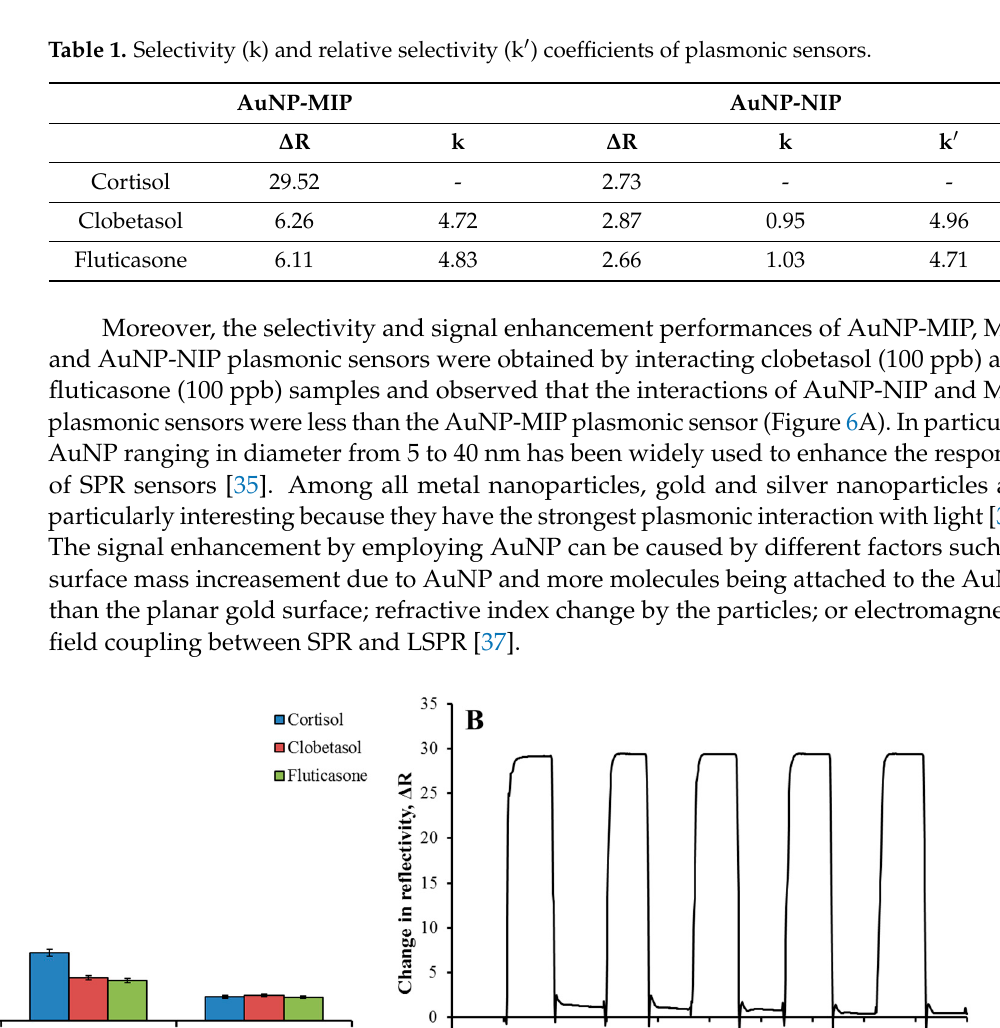
Table 1. Selectivity (k) and relative selectivity (k’) coefficients of plasmonic sensors.